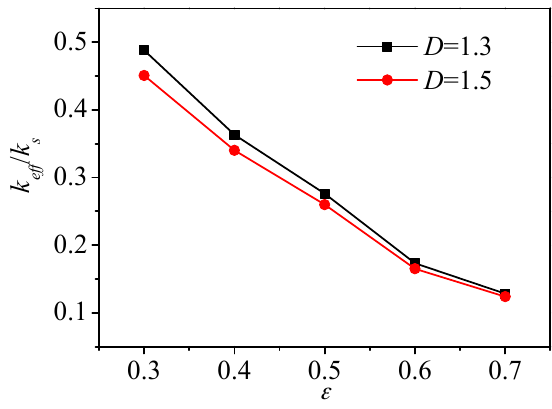
Figure 8. The effect of porosity on the ratio of thermal conductivity.